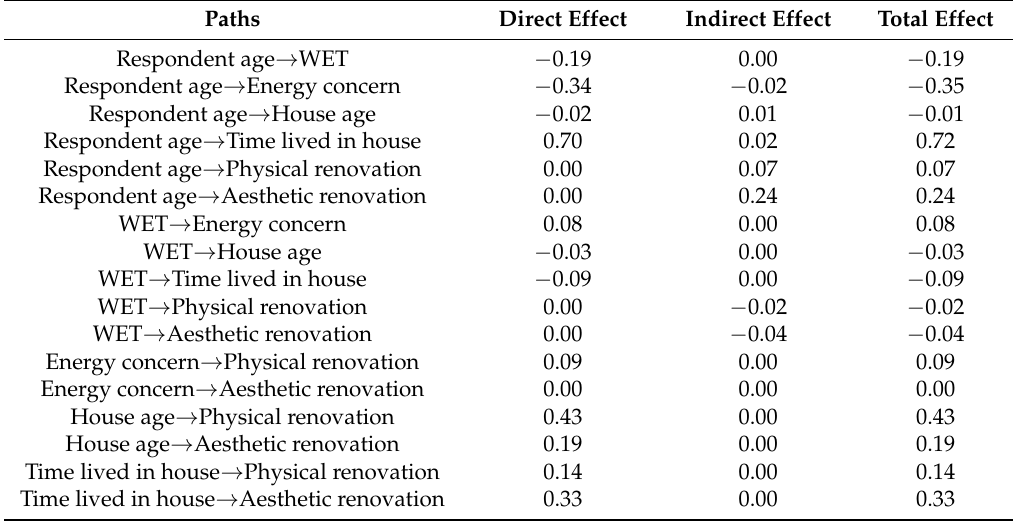
Table 4. Direct, indirect, and total effects for the physical vs. aesthetic renovation